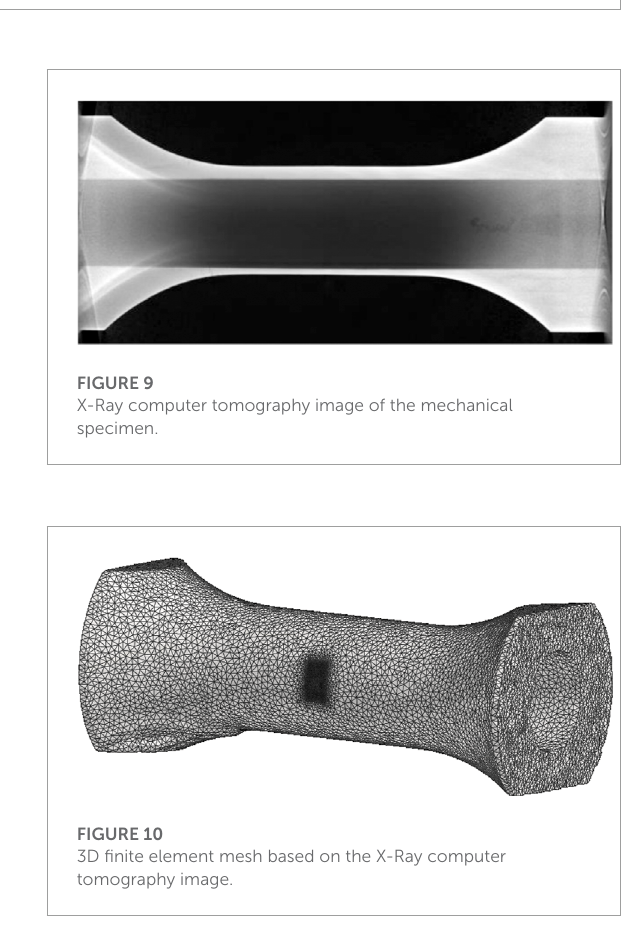
FIGURE 10 3D finite element mesh based on the X-Ray computer tomography